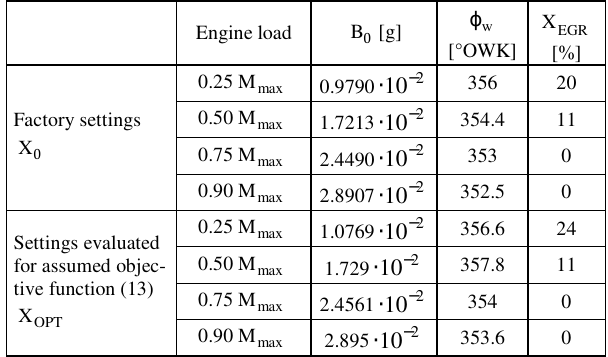
Table 4. Table 4. Factory parameters and optimum